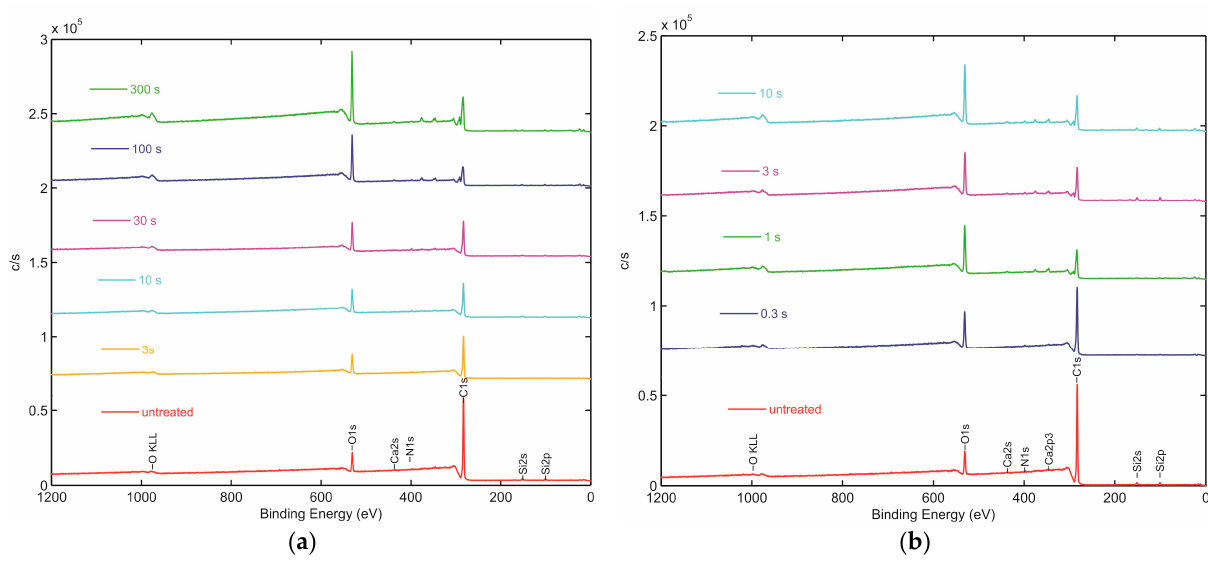
Figure 3. XPS survey spectra of untreated and plasma-treated wheat seeds in the ( a ) E-mode and ( b ) H-mode. ( b )